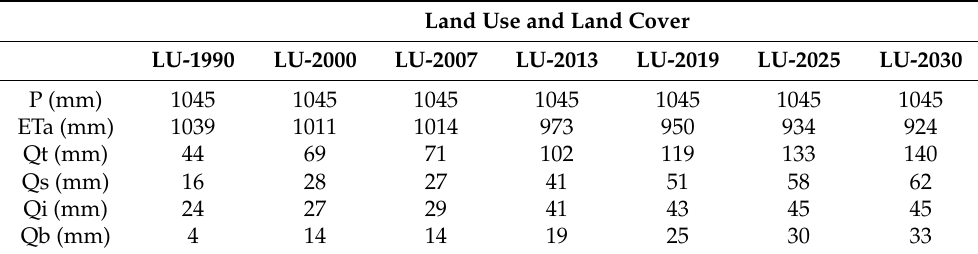
Table 4. Mean annual water balance for each land use land cover for the period of